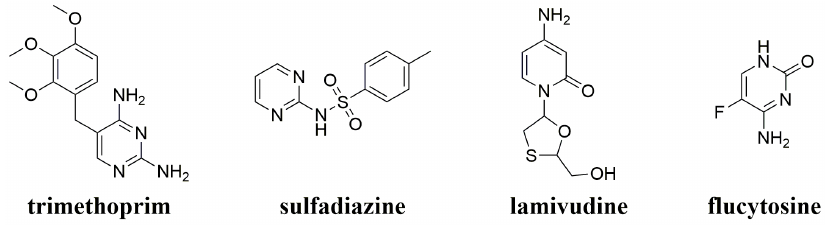
Figure 1. The structures of some commercial drugs containing pyrimidine